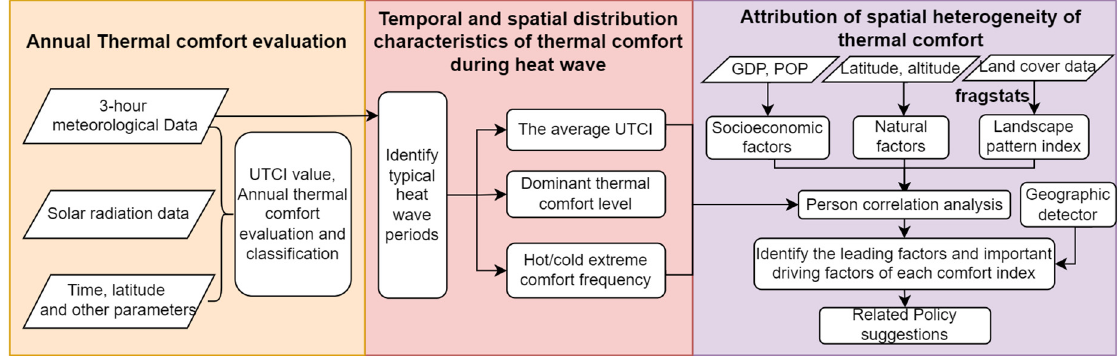
Figure 2. Technical roadmap of the paper.